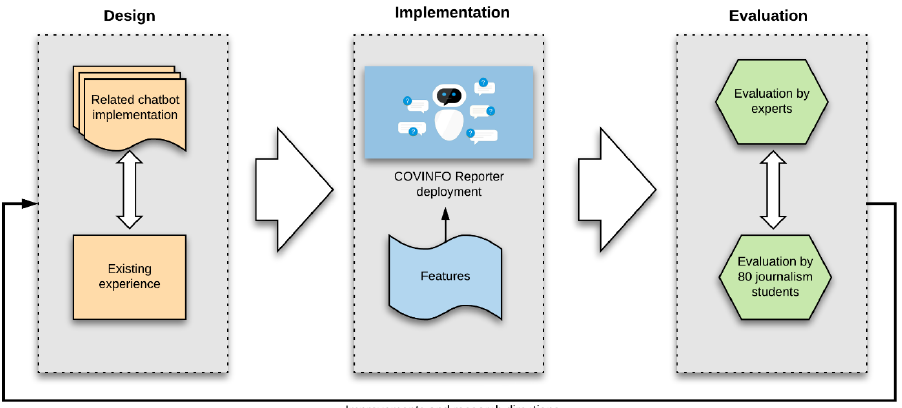
Figure 1. The three steps in the development of the COVINFO Reporter chatbot.